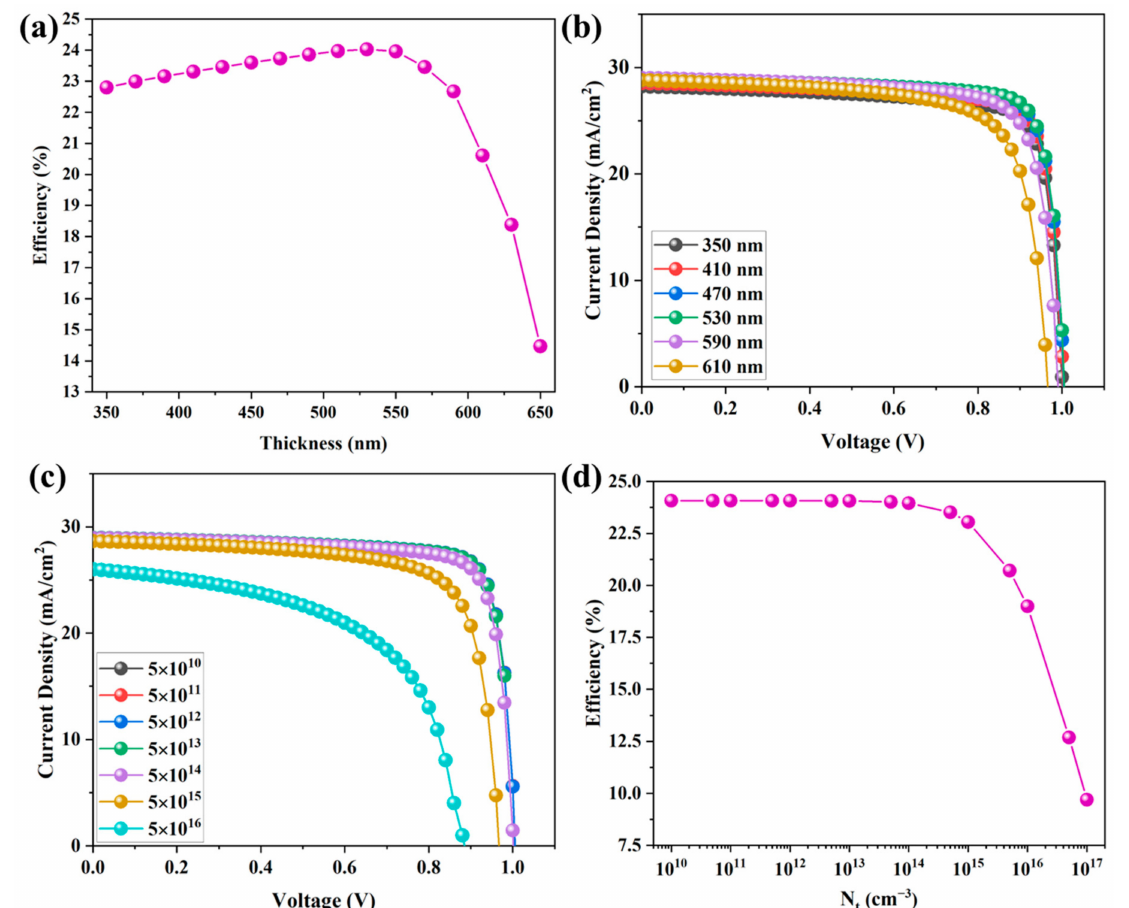
Figure 8. ( a ) Efficiency of solar cells versus thickness of the active layer. ( b ) J-V characteristics of solar cells depending on the FAPbI 3 thicknesses. Effects of defect density on the ( c ) J-V response and ( d ) efficiency of the perovskite solar